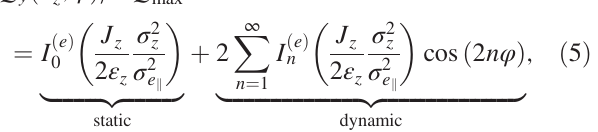
; ϕ Þ , and head-tail spectrum functions H ð z ð 1 Þ ; z ð 2 Þ Þ for electron lenses, an RFQ, z